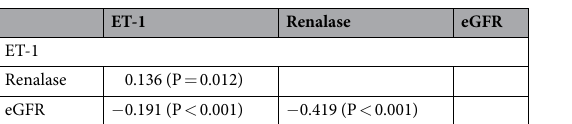
Table 3. Pearson’s correlation coefficients ( r ) for the correlations between serum endothelin-1 (ET-1), renalase and estimated glomerular filtration rate (eGFR). eGFR = estimated glomerular filtration rate, ET-1 =